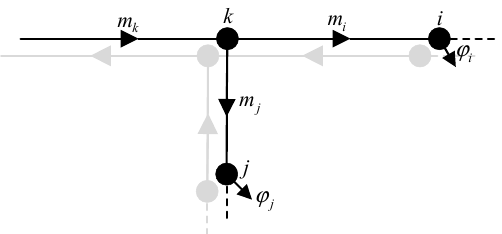
Figure 2. Illustration describing the calculation of the mass flow rates correlation coefficient.